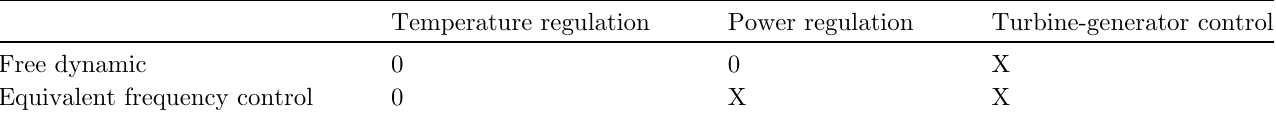
Table 2. Role of the equivalent frequency control considered in this paper and associated